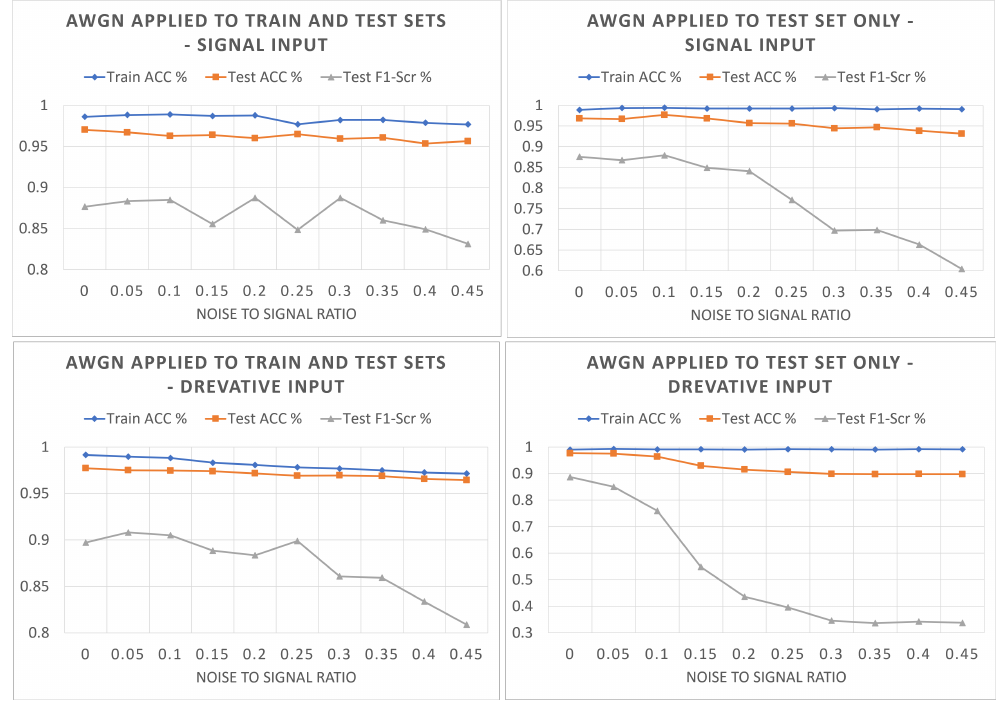
Figure 7. The performance of the proposed MF classifier in the presence of